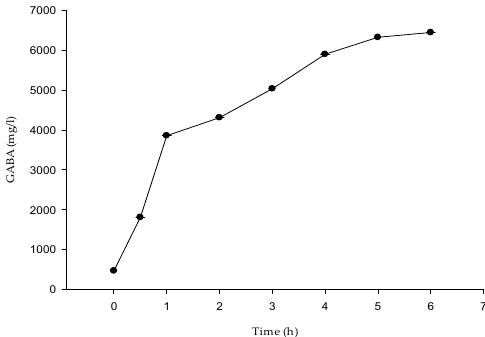
Figure 8. Enzymatic conversion of MSG to GABA using purified recombinant GAD from L. plantarum FNCC 260. The conversion was performed using 0.64 U/mL of GAD in 2 mL of 50 mM citrate- phosphate buffer (pH 4.5) containing 100 mM MSG and 0.2 mM PLP at 30 °C . Data expressed as mean ±SD with SD less than 5%. The experiments were conducted at least in duplicate.